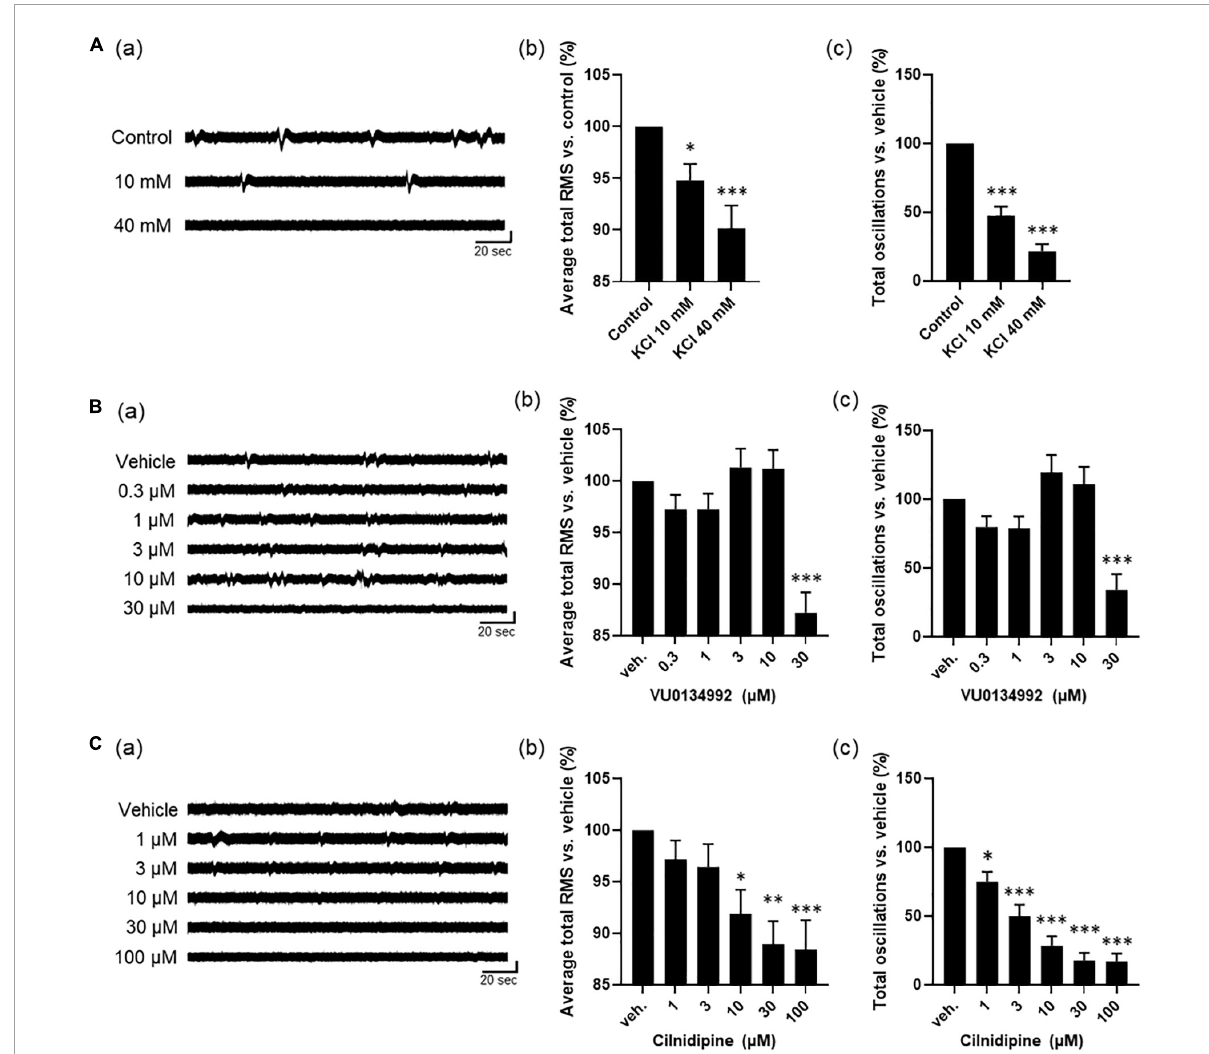
FIGURE3 Astrocyte activity depends on ion channel modulations. (A) high potassium experiments by cumulative administration of KCl ( n = 5). (a) Representative oscillation waveform. (b) Average total RMS and (c) Total oscillations. (B) Inhibitory experiment by VU0134992 ( n = 6). (a) Representative oscillation waveform. (b) Average total RMS and (c) Total oscillations. (C) Inhibitory experiment by cilnidipine ( n = 4). (a) Representative oscillation waveform. (b) Average total RMS and (c) Total oscillations. KCl and inhibitors were added to astrocytes at 7 DIV. One-way ANOVA followed by Dunnett’s test, ∗ p < 0.05, ∗∗ p < 0.01, ∗∗∗ p < 0.001 versus control/vehicle. Error bar,